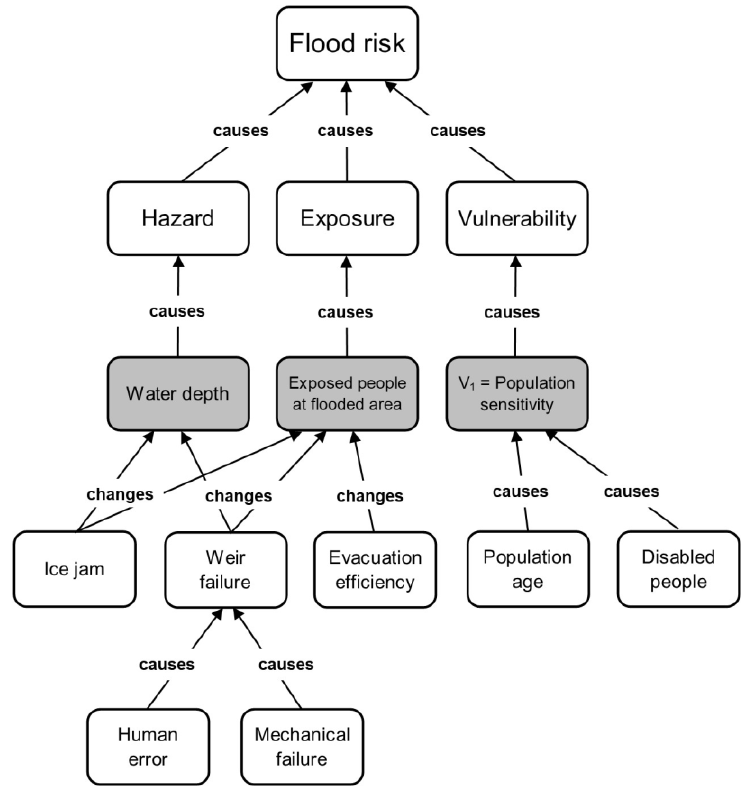
Figure 9. Causal network representing the expanded flood risk model.